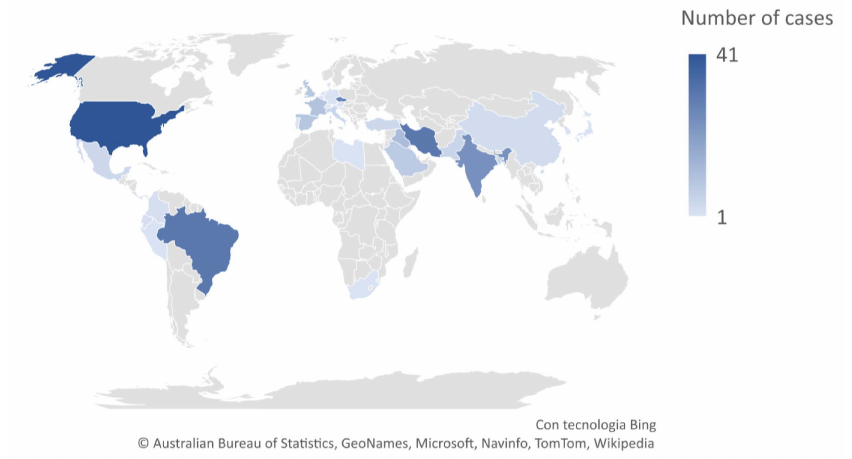
Figure 2. Distribution of cases worldwide.